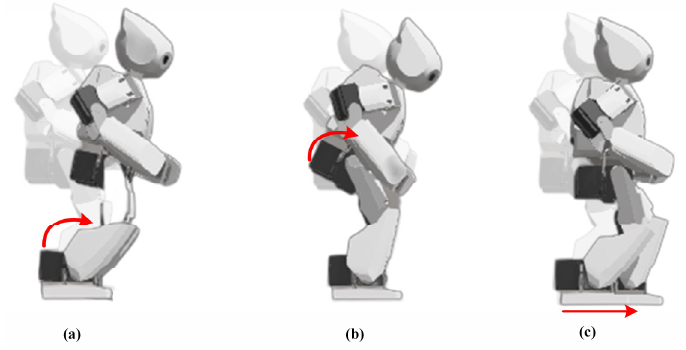
Figure 14. Balancing strategies: ( a ) ankle, ( b ) hip, ( c ) step.